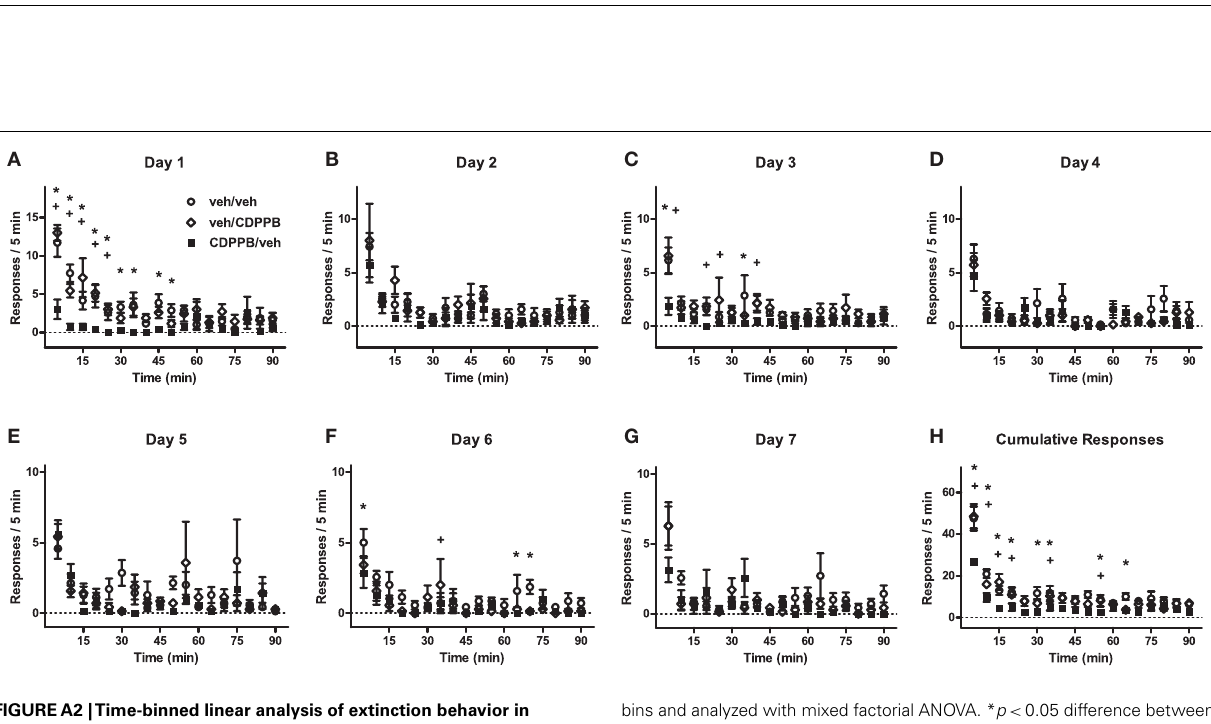
FIGUREA1 |Time-binned linear analysis of extinction behavior in Experiment 1. (A–G) Mean ( ± SEM) number of active lever responses from Days 1–7 of the first extinction training sequence, and (H) the per-subject average ( ± SEM) of cumulative responses, which were categorized into 5-min